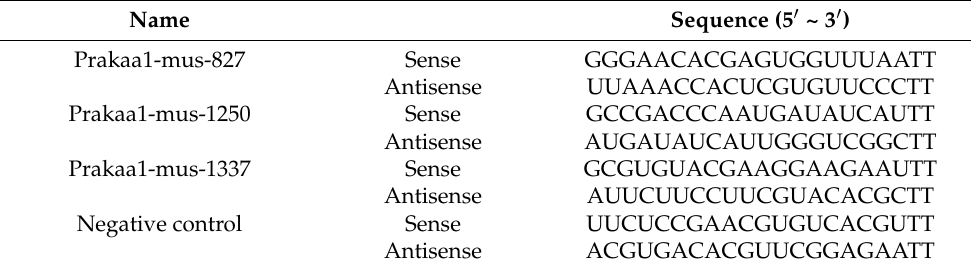
Table 2. Sequences of synthetic siRNAs used for transient